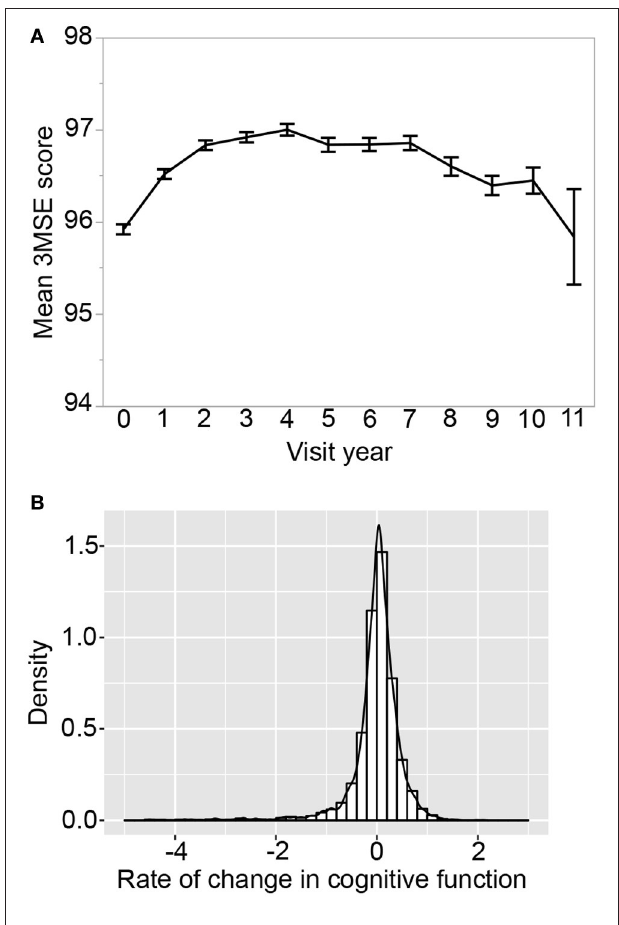
FIGURE 2 | Cognitive change over time. (A) Longitudinal plot of average 3MSE scores from baseline and up to 11 years of annual follow-up visits. On average, there are N = 3,166 participants per year, and this decreased to only 239 participants by year 11. Error bar is standard error. (B) Distribution of rate-of-change shows significant variation in cognitive aging trajectories among participants. Four thousand two hundred eighty-four WHIMS participants with 3MSE scores available at baseline and at least two follow-up visit years were used to derive regression slope over